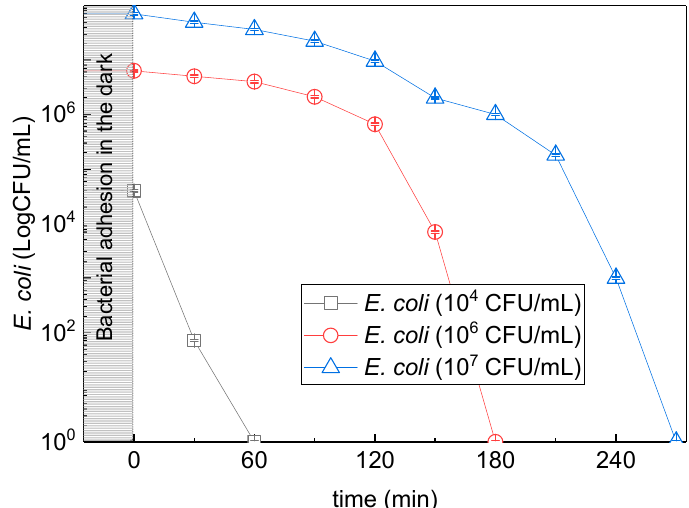
Figure 6. E. coli inactivation on AgNPs–TiO 2 ceramic tiles under low intensity solar simulated light (50 mW/cm 2 ) at different E. coli initial concentrations.